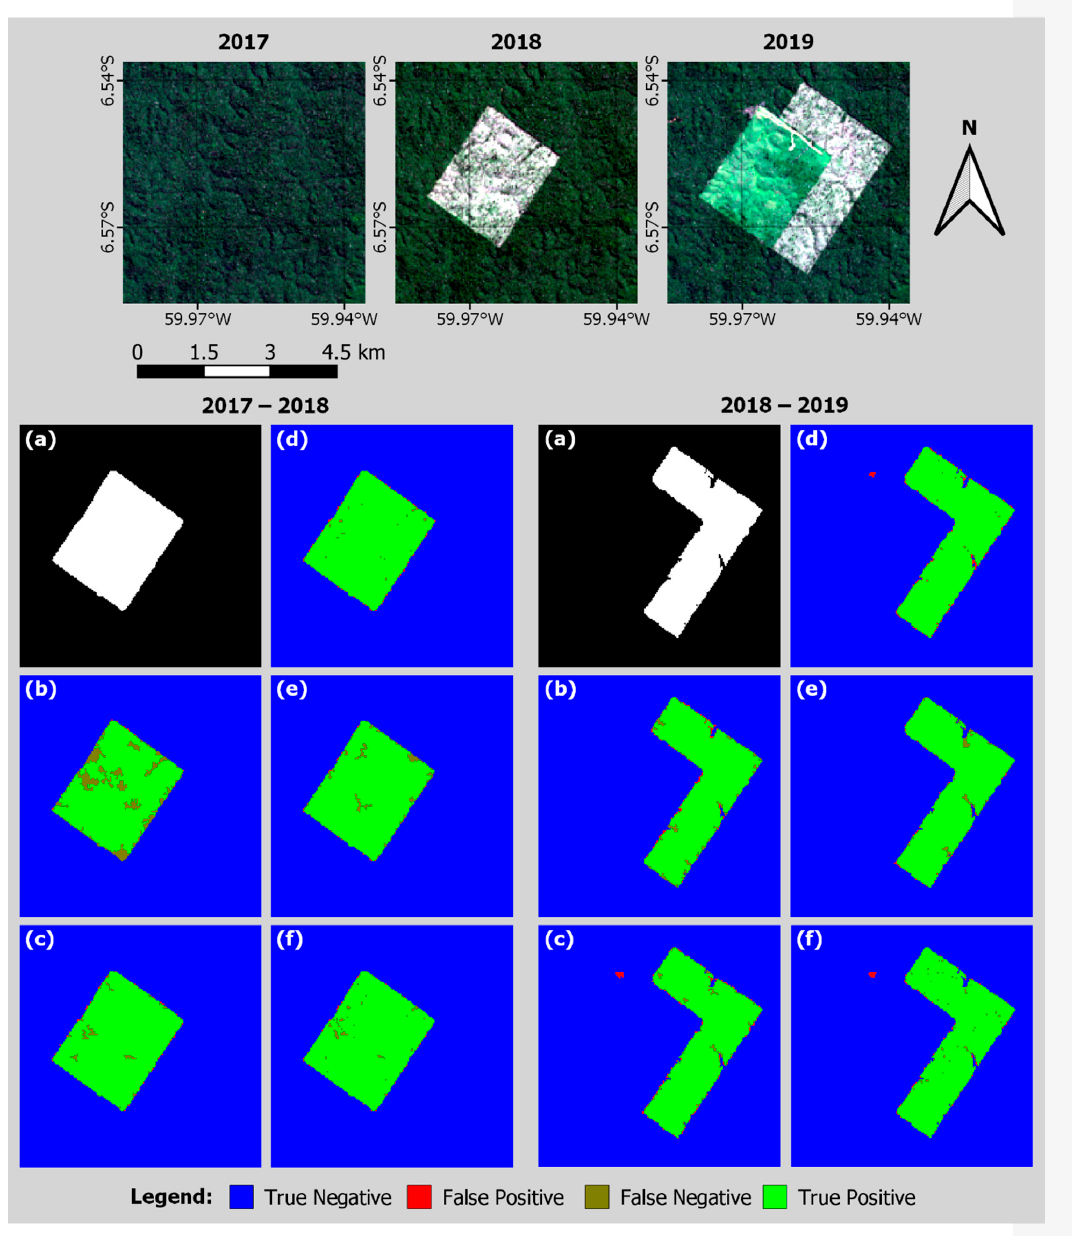
Figure 9. First example location within the test site with the ( a ) ground truth and classifications made by the ( b ) RF, ( c ) MLP, ( d ) SharpMask, ( e ) U-Net, and ( f ) ResUnet models in each time sequence.